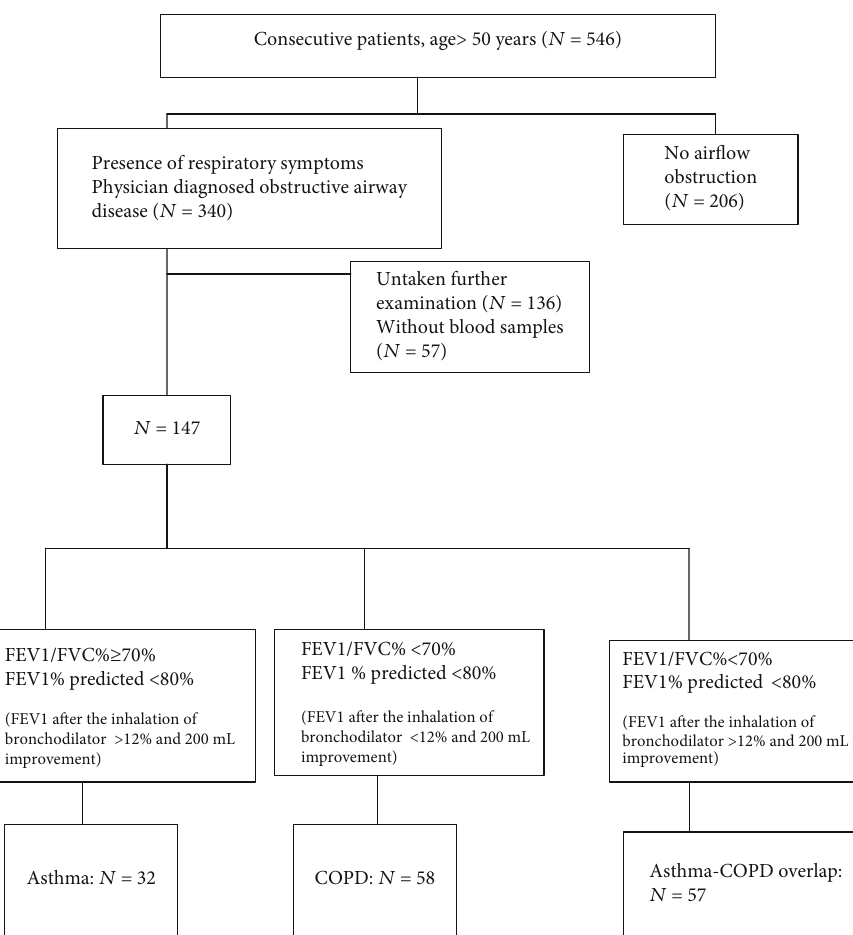
Figure 1: The fl owchart of the study population. COPD: chronic obstructive pulmonary disease; FEV1: forced expiratory volume in 1 s; FVC: forced vital